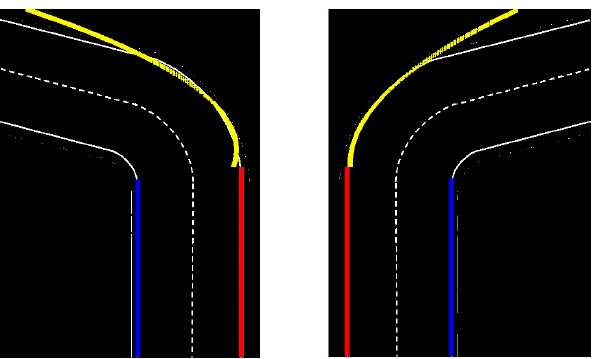
Figure 5. Left and right turning on the road.